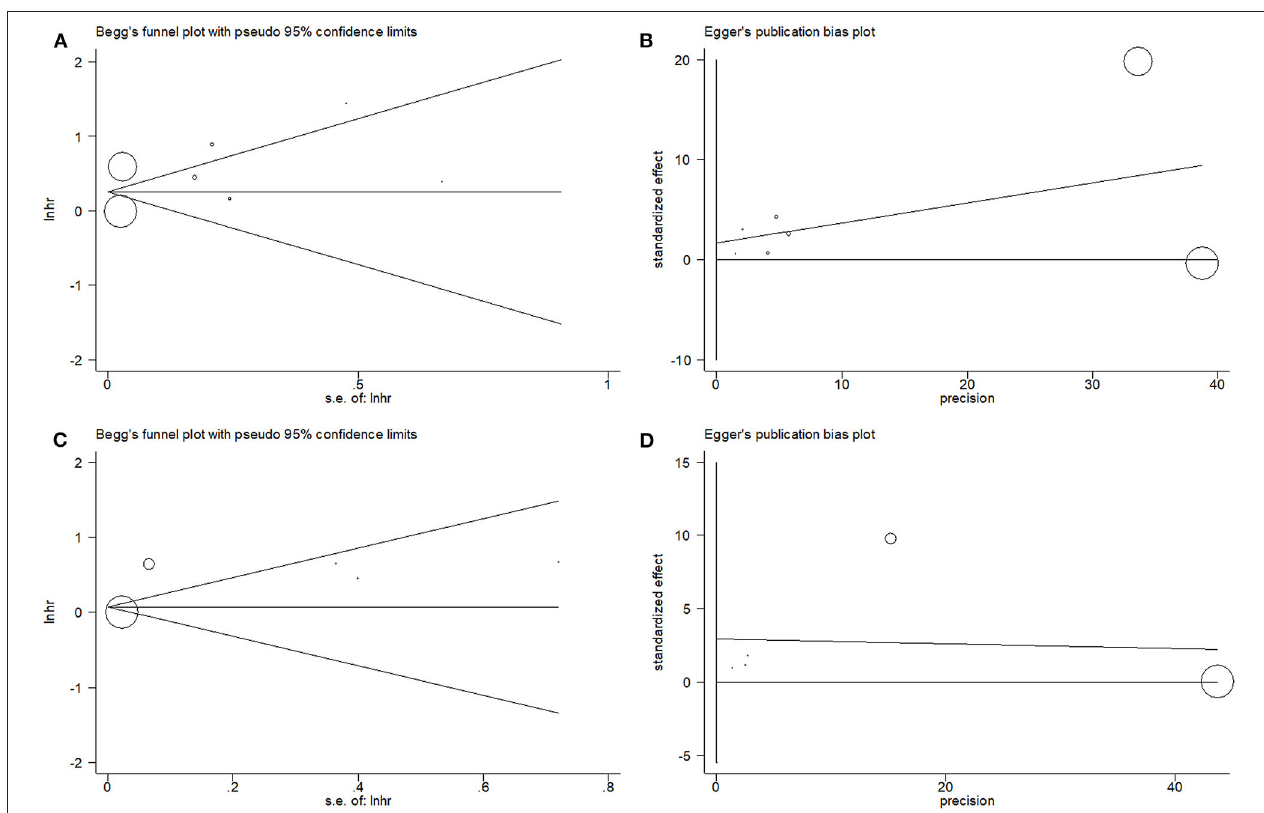
FIGURE 4 | Begg’s funnel plot and Egger’s test to evaluate publication bias. (A) Begg’s test for overall survival (OS); (B) Egger’s test for OS; (C) Begg’s test for progression-free survival (PFS); and (D) Egger’s test for PFS.